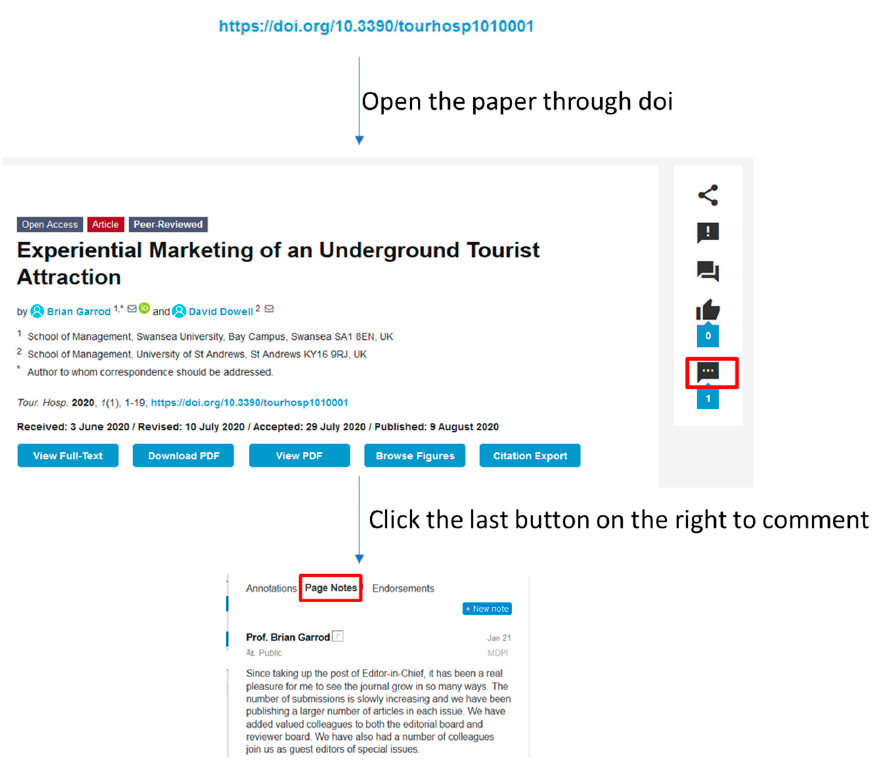
Figure 1. Schematic diagram of how to use the comments facility on the journal website.